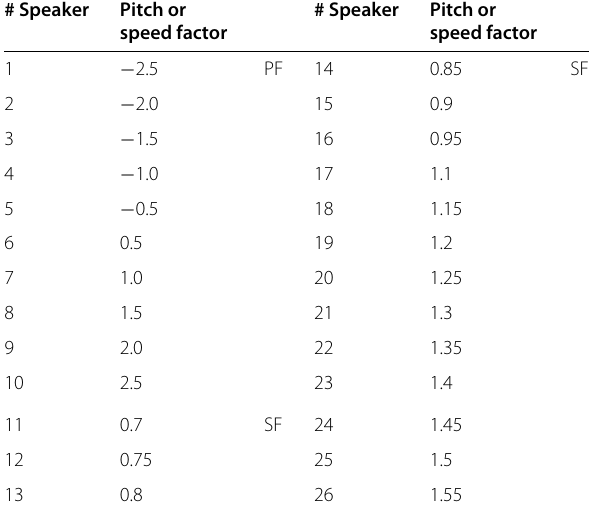
Table 6 Number of semitones of pitch shift (PF), or ratio of speed of the new speech to speed of the original speech (SF), used when generating augmented data from the original data, for